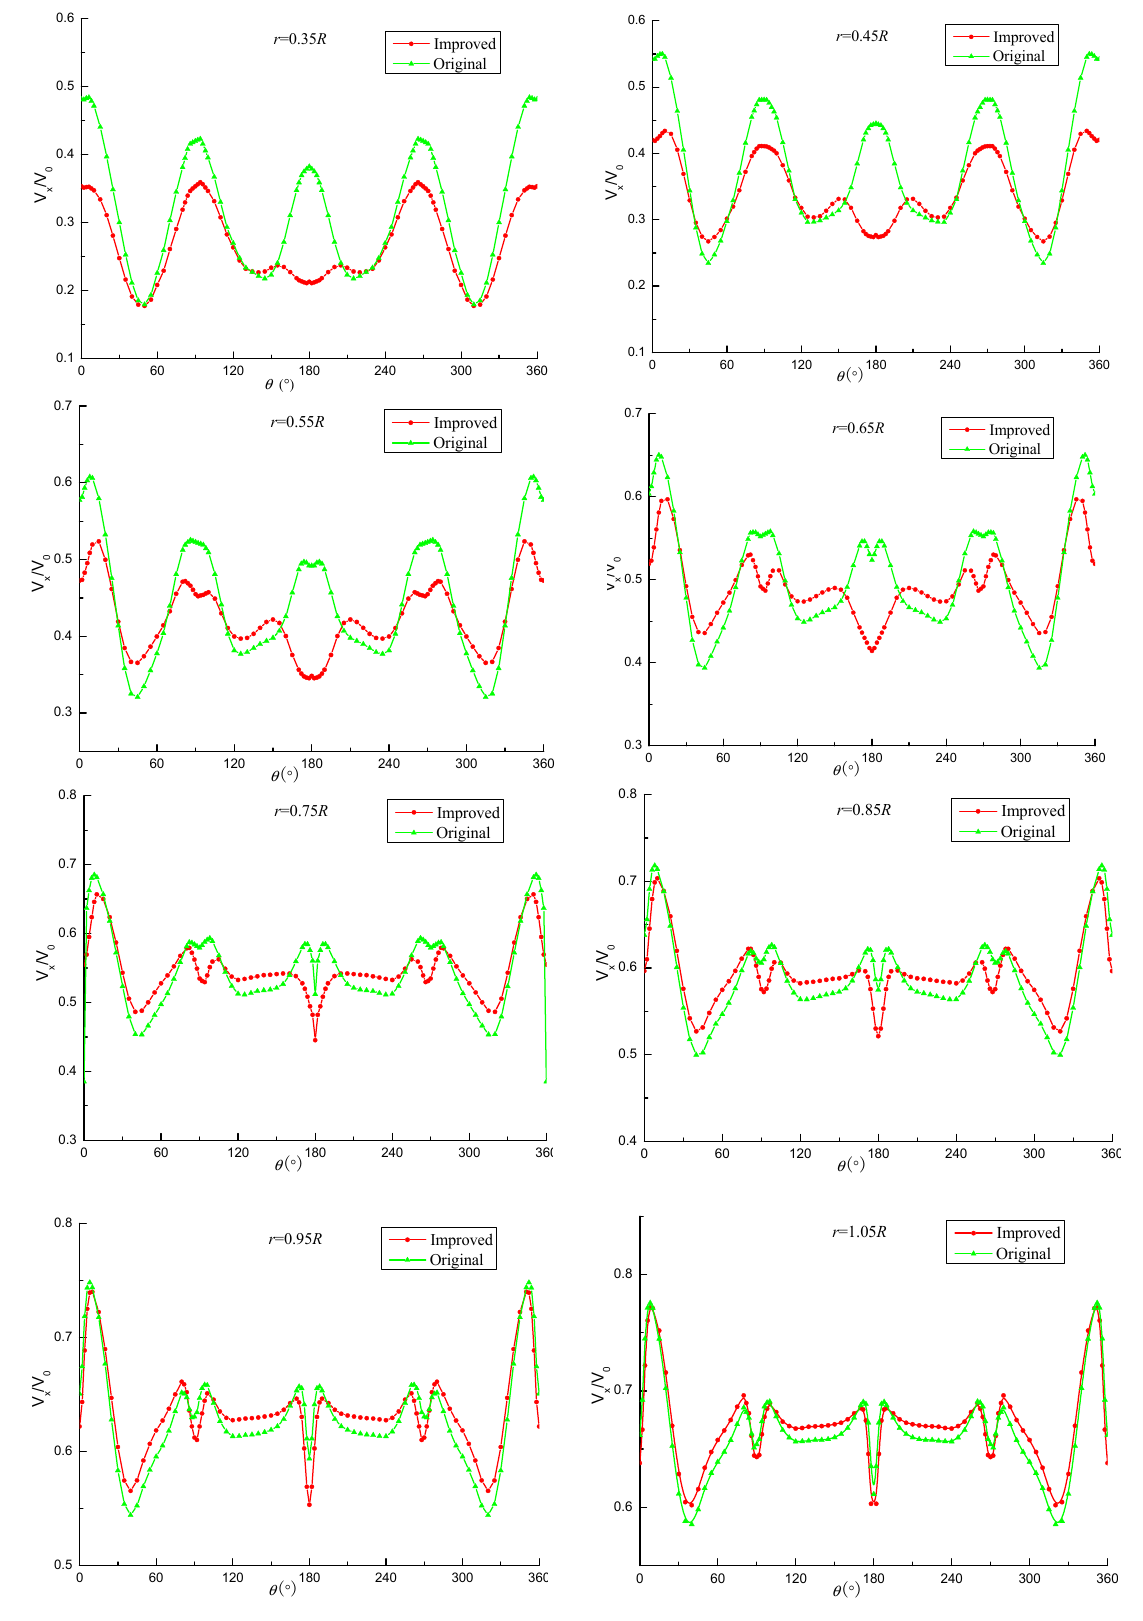
Figure 10. The circumferential distribution of the axial velocity.